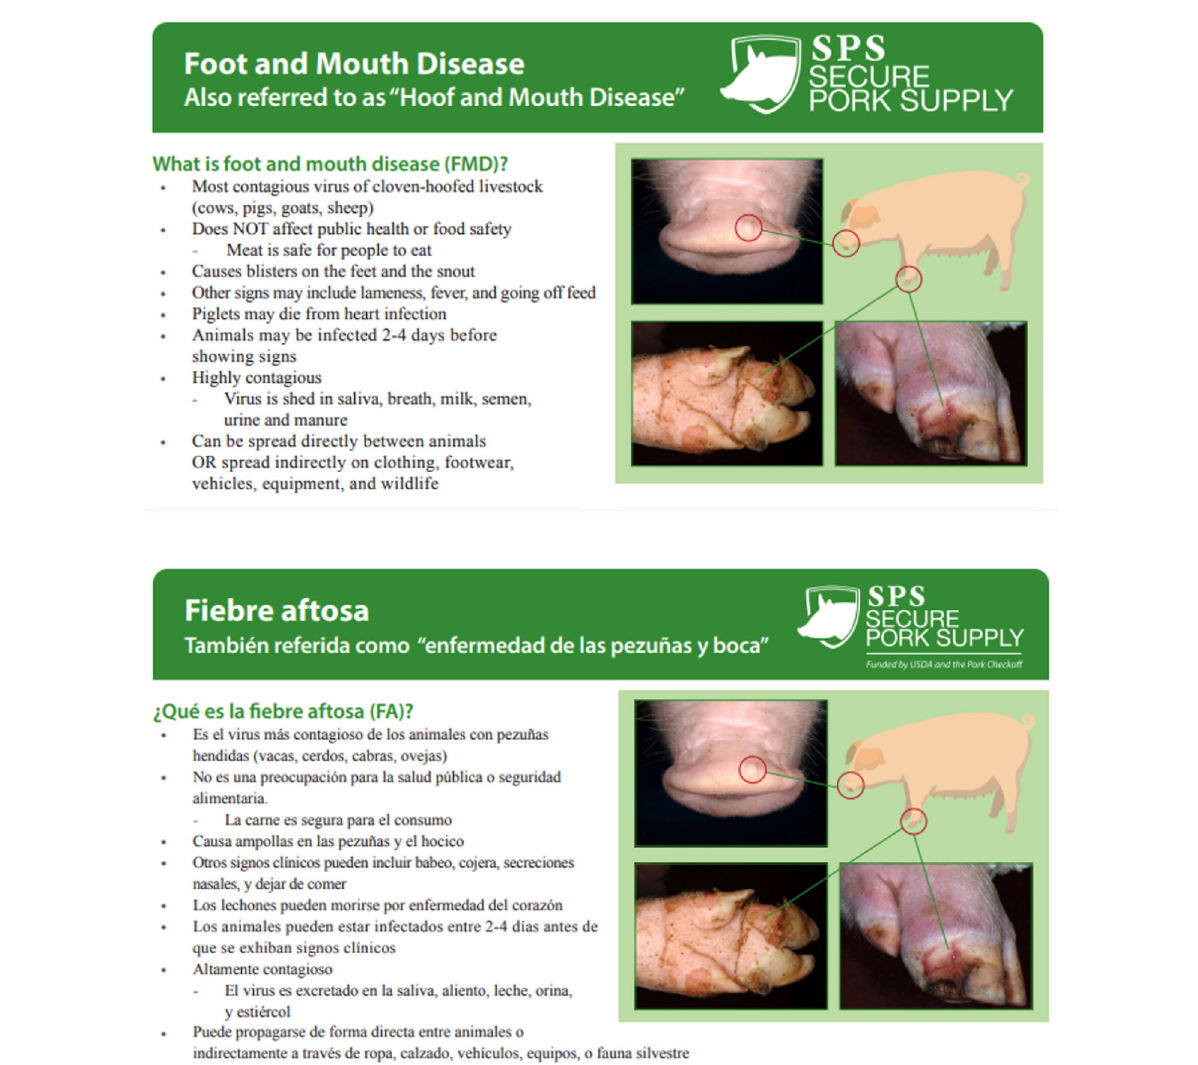
FIGURE1 Multi-lingual biosecurity resources concerning foot and mouth disease (credit: Secure Pork Supply).